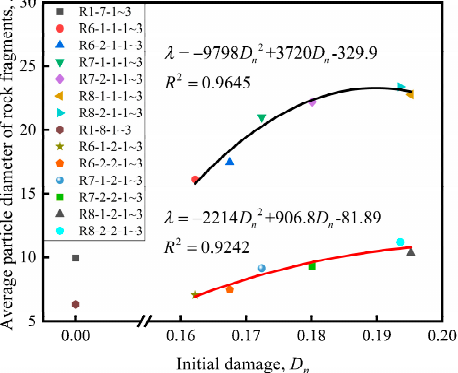
λ under different initial damage